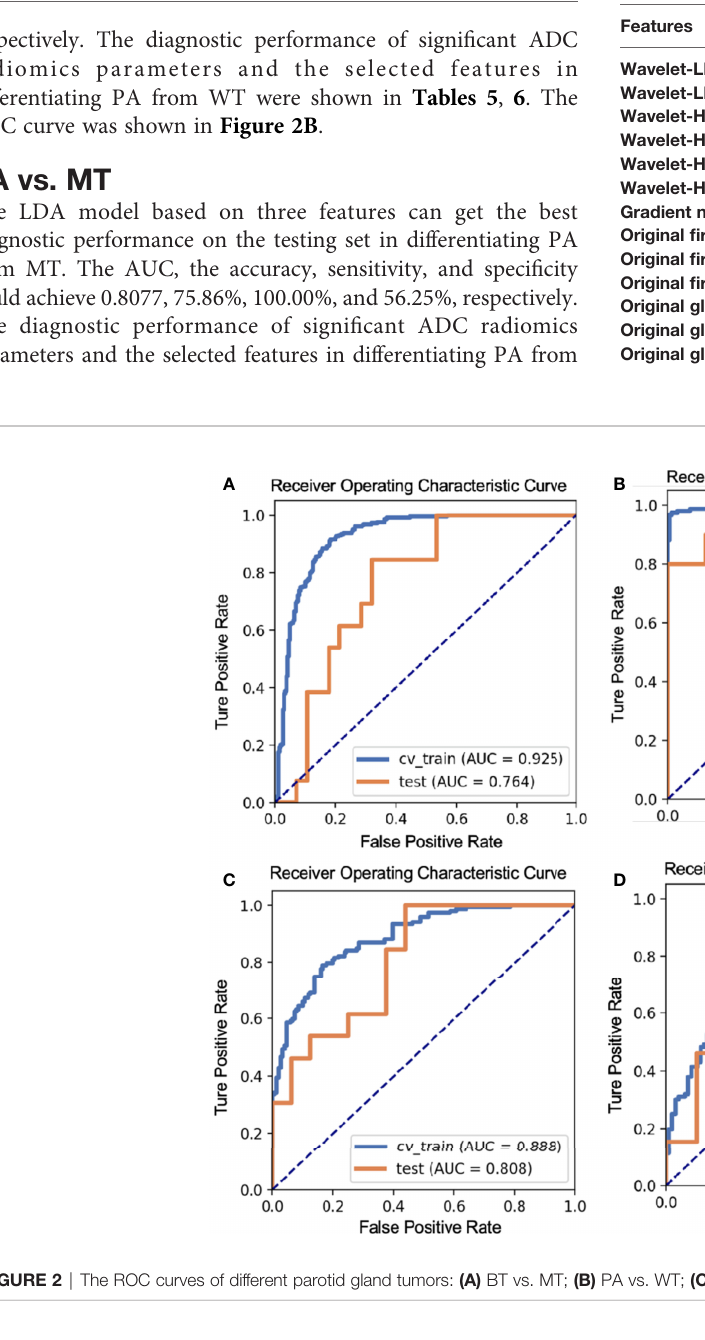
TABLE 6 | The coef fi cients of features in the